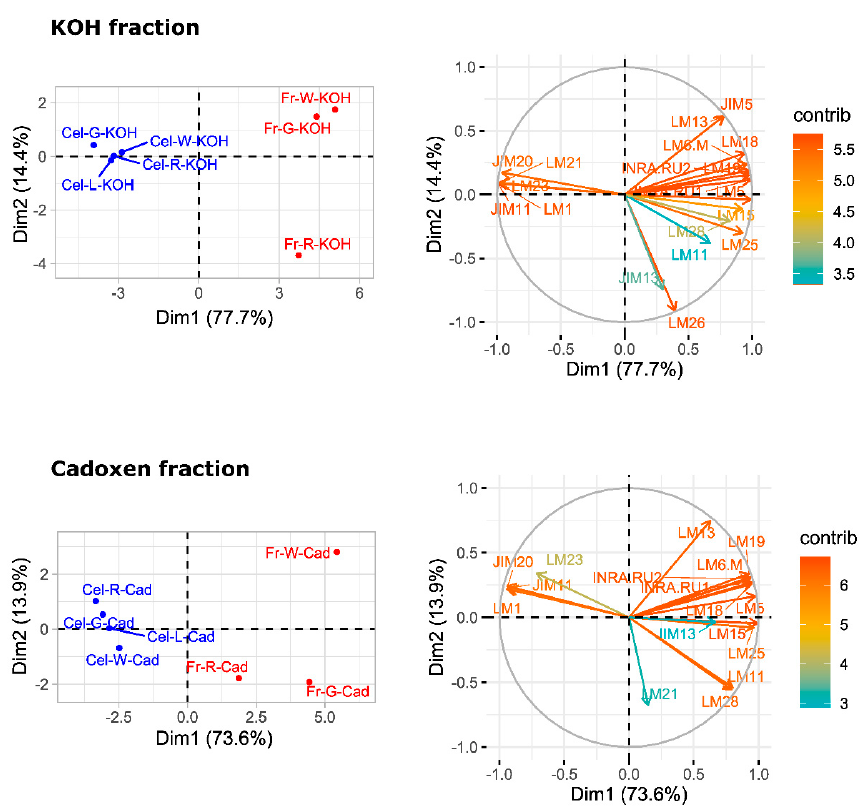
Figure 8. PCA analysis of carbohydrate microarray data from matrix glycan fractions, xyloglucans (KOH), and cadoxen fractions. The factor score plots are shown in the left and the variable plots in the right . The color scale in the variable plots represents the average contribution of the variable to the variation explained by the two principal components. Fr: fruit; Cel: callus culture; G: green stage; W: white stage; R: red stage; KOH: 4M KOH fraction; Cad: cadoxen fraction.